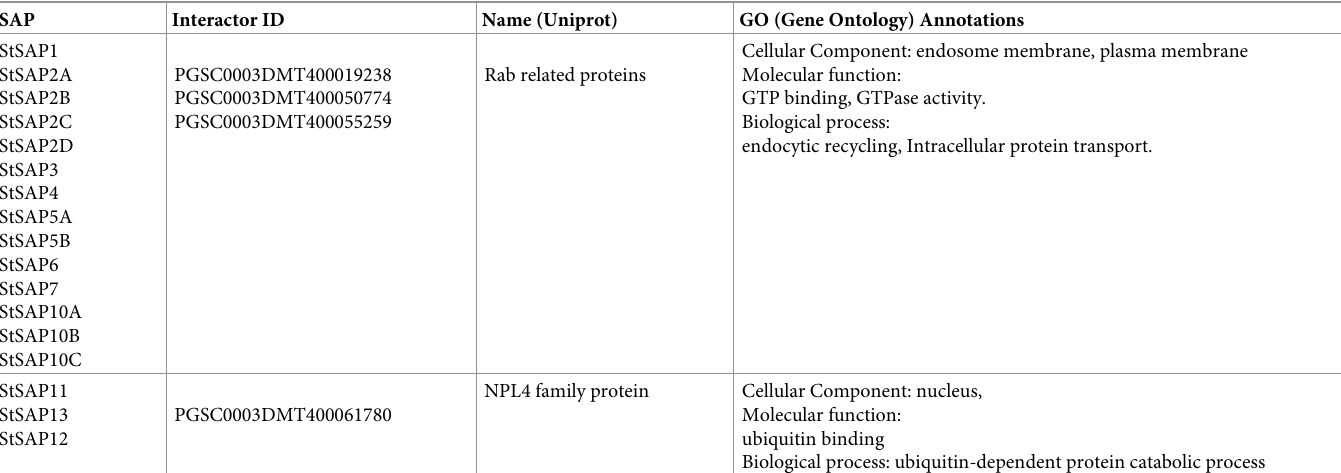
Table 4. Potential protein interactor partners of the stress associated proteins (SAP) using STRING database.